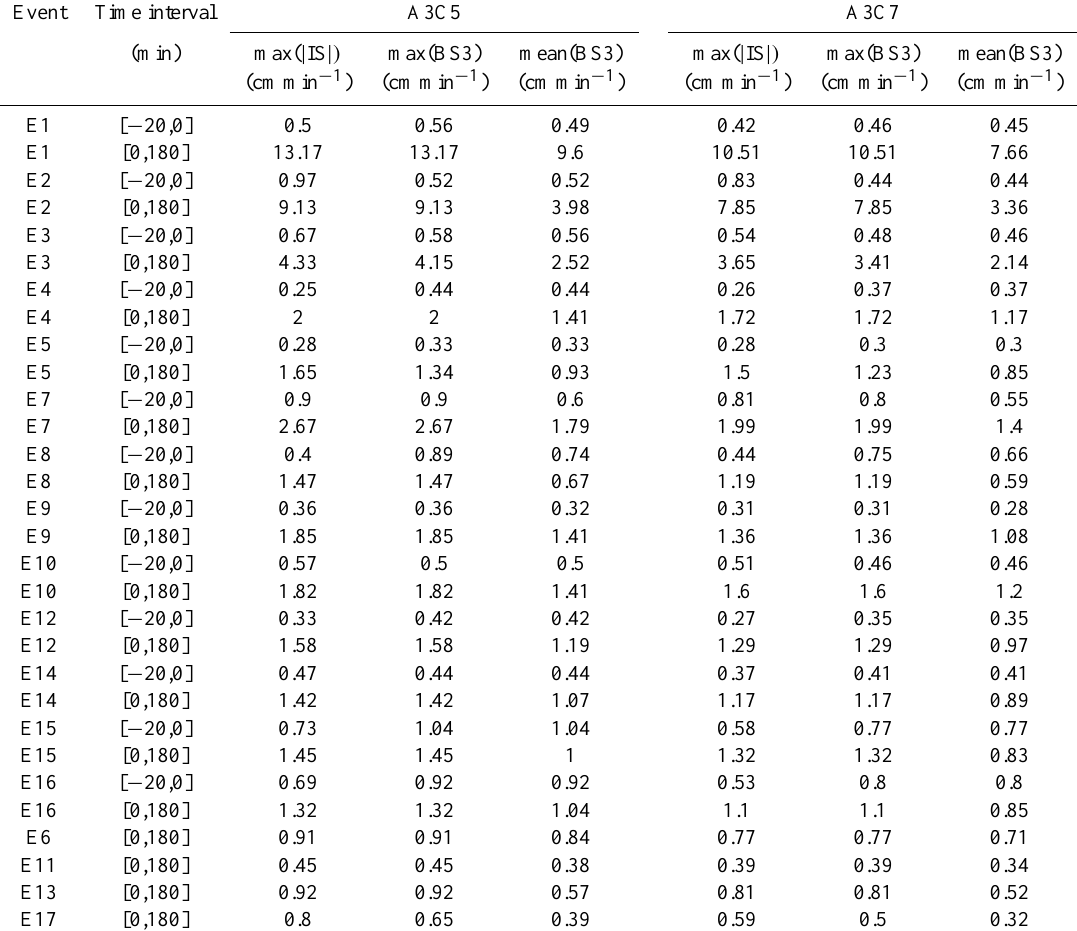
Table 7. Values of TEDA functions IS and BS3 within the tsunami Detection Window (DW) and within the preceding time interval of 20min length for both configurations A3C5 and A3C7. Time is measured from the beginning of the Tsunami Interval (TI). It is interesting to compare the maximum value of BS3 in the 20min long interval with the maximum IS value of the Detection Window. Notice that for events E6, E11, E13, E17, the function | IS | remains below the threshold λ IS = 1cmmin − 1 within the entire Detection